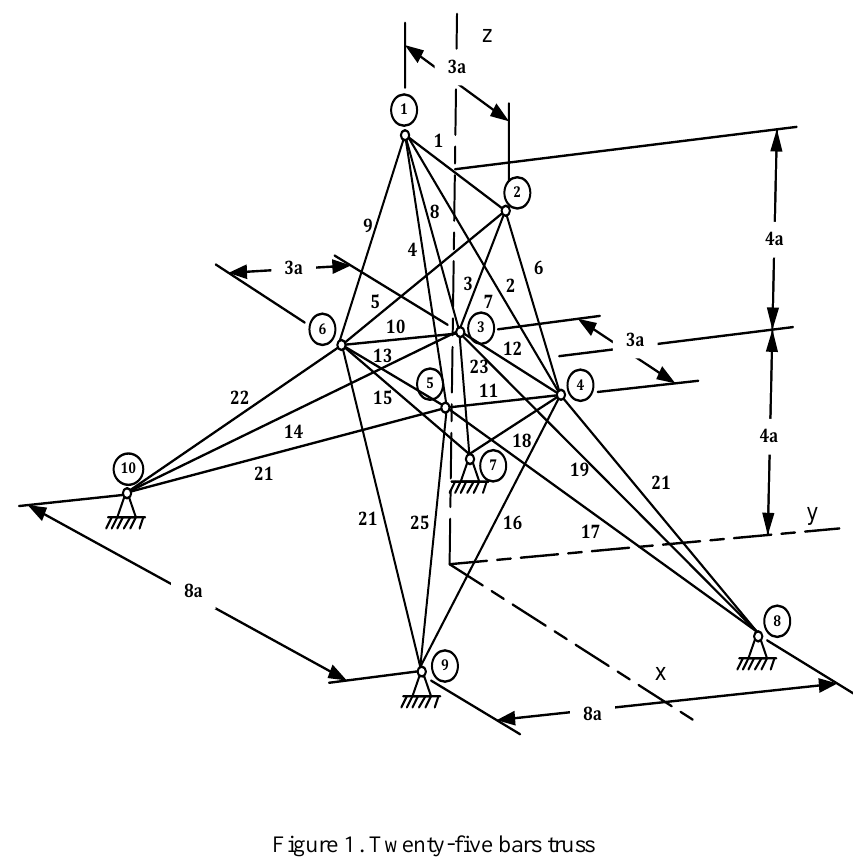
Figure 1. Twenty-five bars